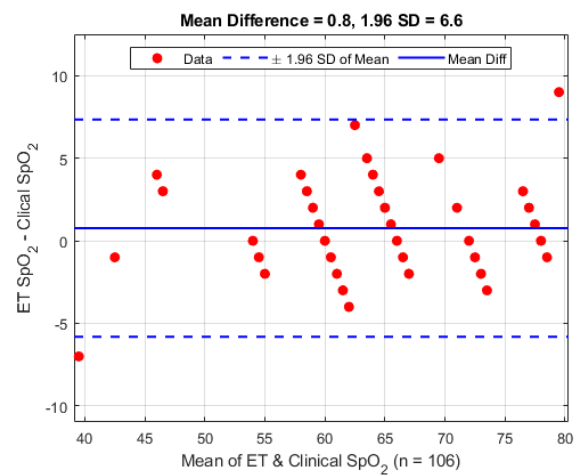
Figure 11. Bland–Altman analysis of pulse rate from the periphery sensor vs. the clinical monitor.